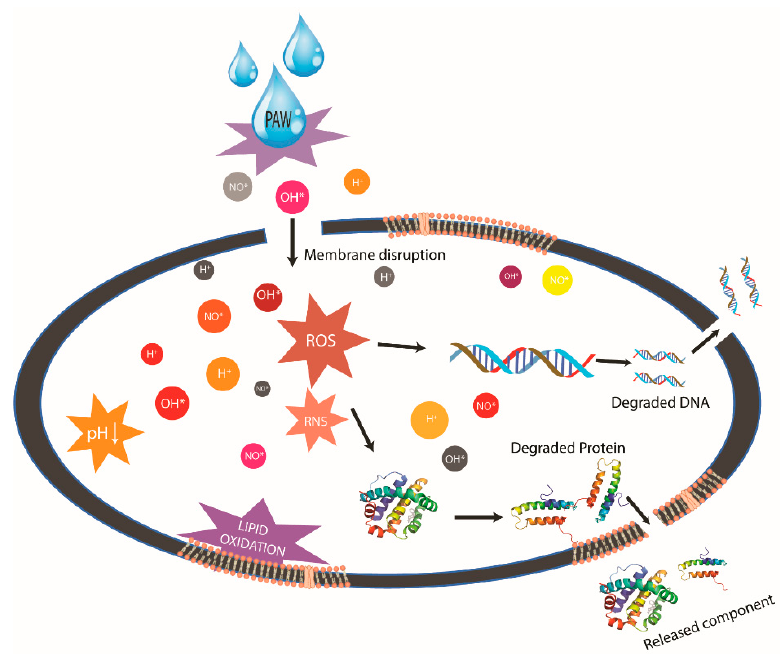
Figure 2. Antimicrobial mechanisms of PAW.